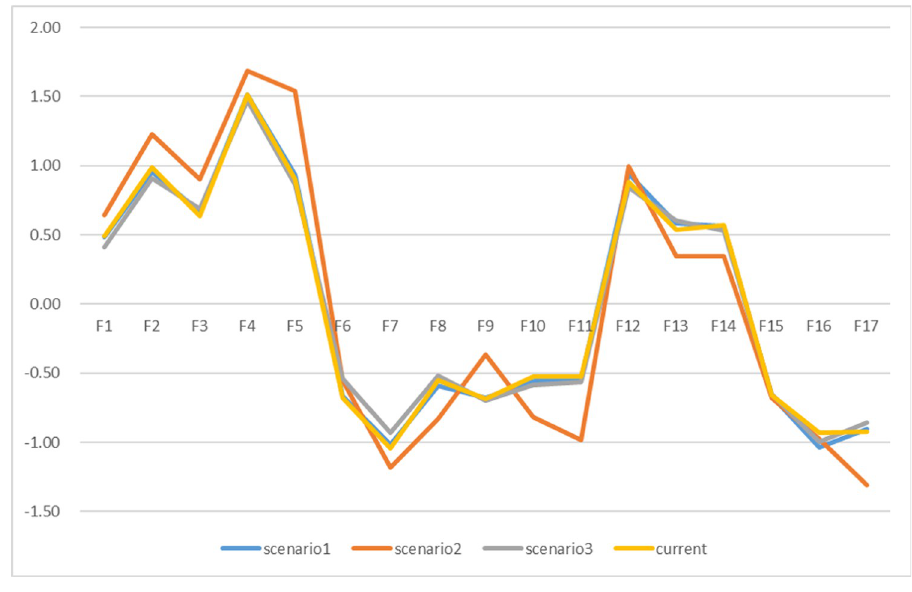
Fig 5. Sensitivity analysis of R-C